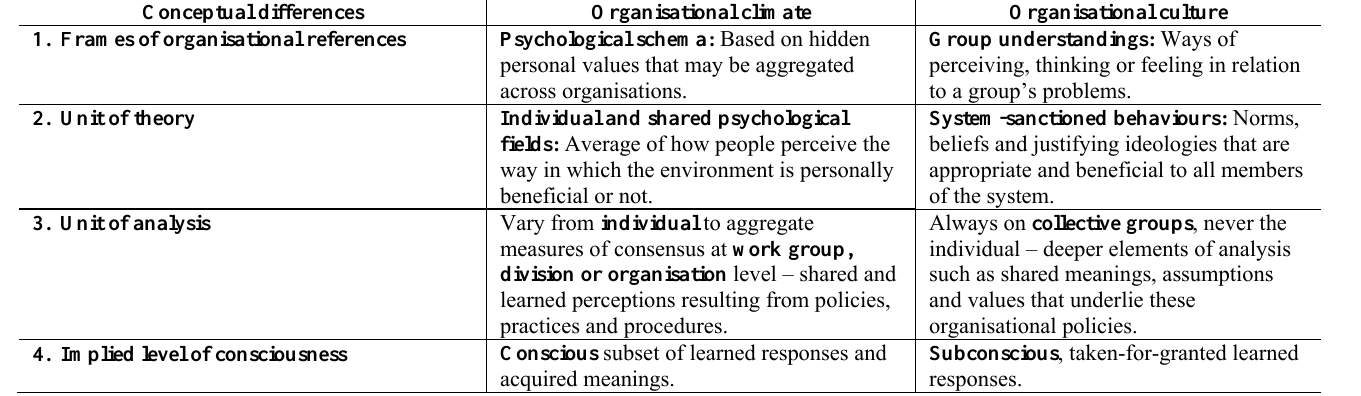
Table 1: Conceptual differences between organisational climate and culture Conceptual